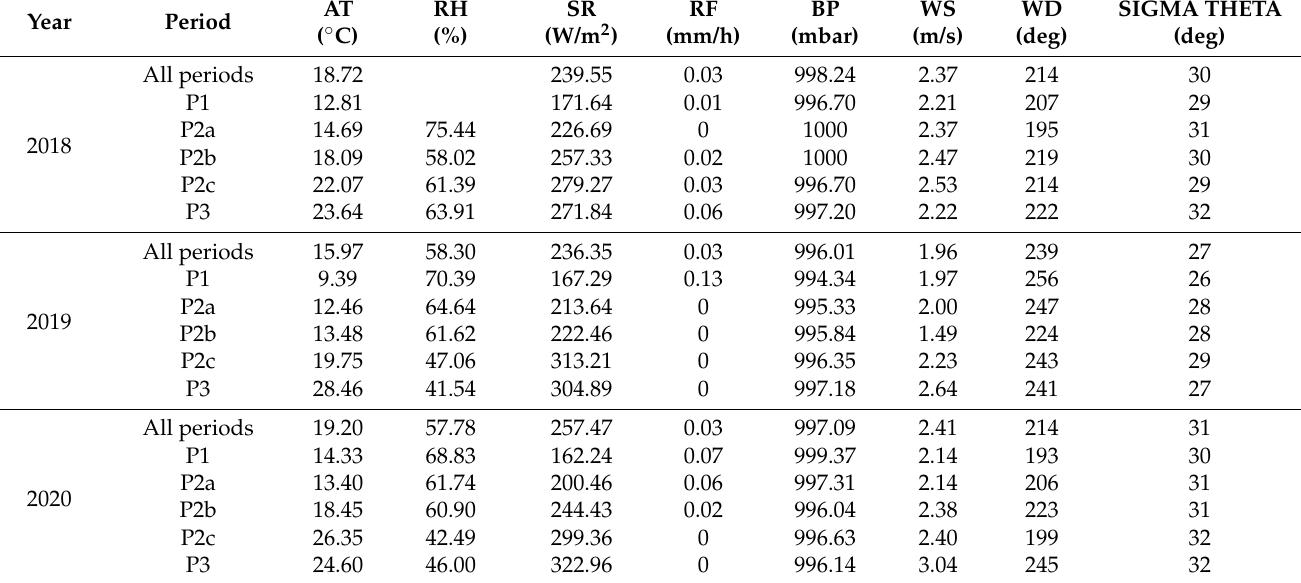
Figure 9. ( a ) The daily average of PM 2.5 concentrations 2020 at three different stations: the AURA station (red), the AGM background station (black line) and for NicTr station (orange line). ( b ) The average daily variation of PM 2.5 concentrations in coloured line at the AURA station 2020. (Black line denotes the trend line of the daily average (using the LOESS method), and the grey shaded area denotes their corresponding standard deviation.) ( c ) The box plots of the PM 2,5 concentrations at the three stations, AURA (red), AGM (black) and NicTr (orange). Table 7. The average values of the study periods of the AURA station in 2018, 2019 and 2020 for the ambient temperature (AT), relative humidity (RH), solar radiation (SR), rainfall (RF), barometric pressure (BP), wind speed (WS), wind direction (WD) and sigma theta